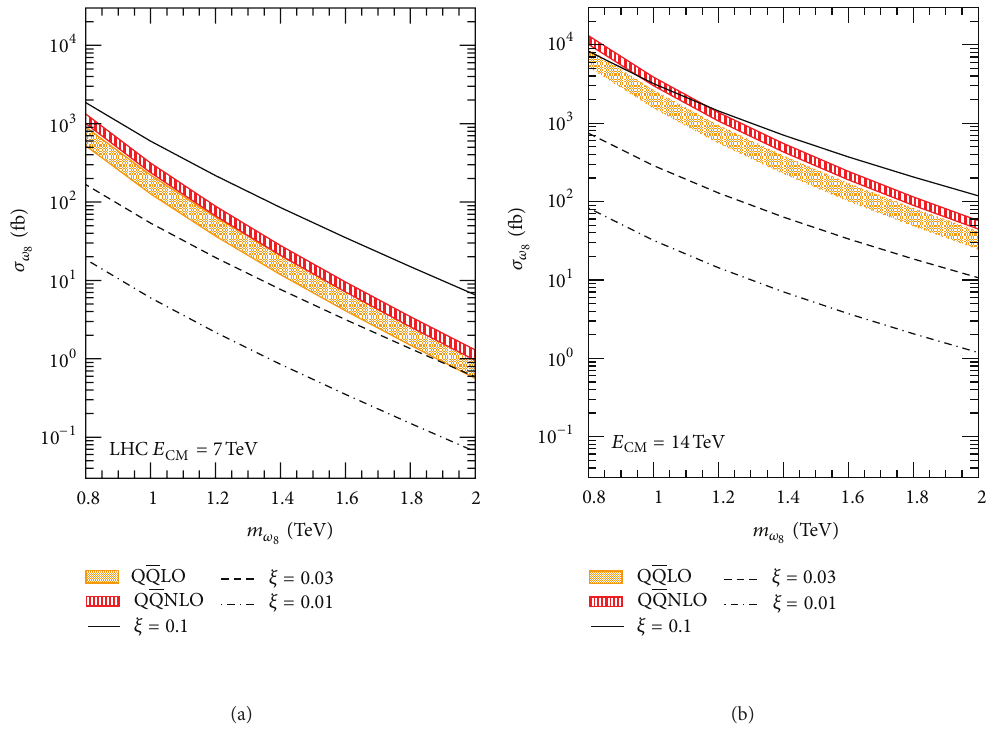
/𝑚 𝑄𝑄 𝜔 8 values. The open 8